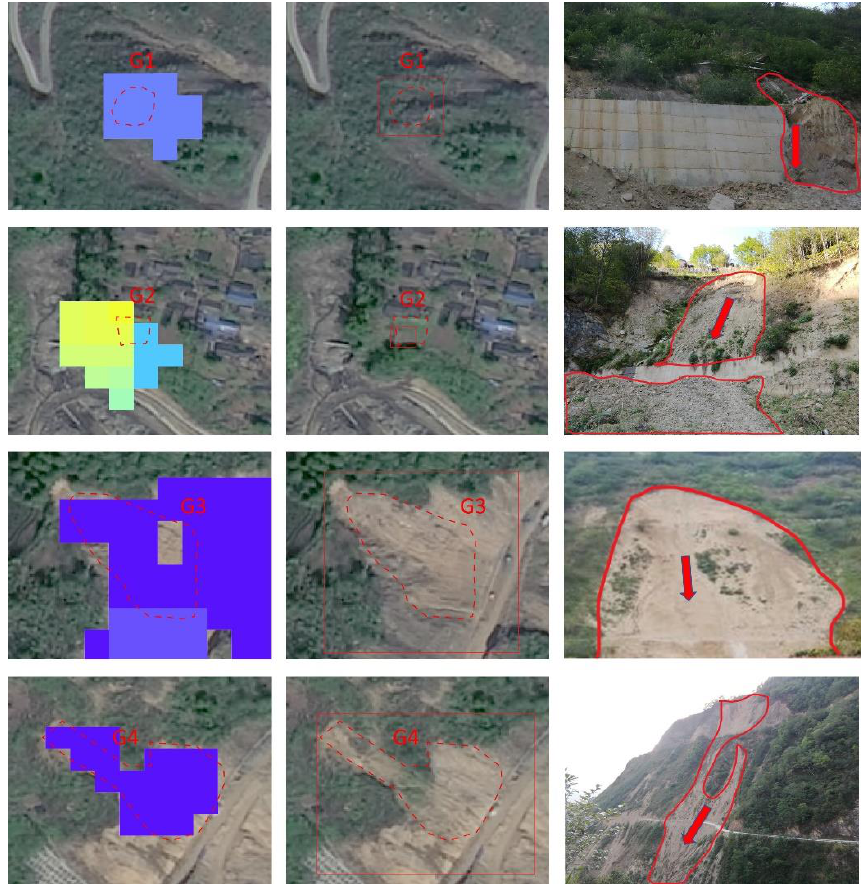
Figure 11. Examples of landslides identified by (from left to right) SBAS-InSAR, Yolo, and verified field work. Here, the color pixels in left panels indicate the scatter points; red rectangles and dotted polygons in middle panels represent the Yolo result and reference, respectively; the polygons in right panels indicate the landslides delineated in field work and the arrow displays the main slide direction.